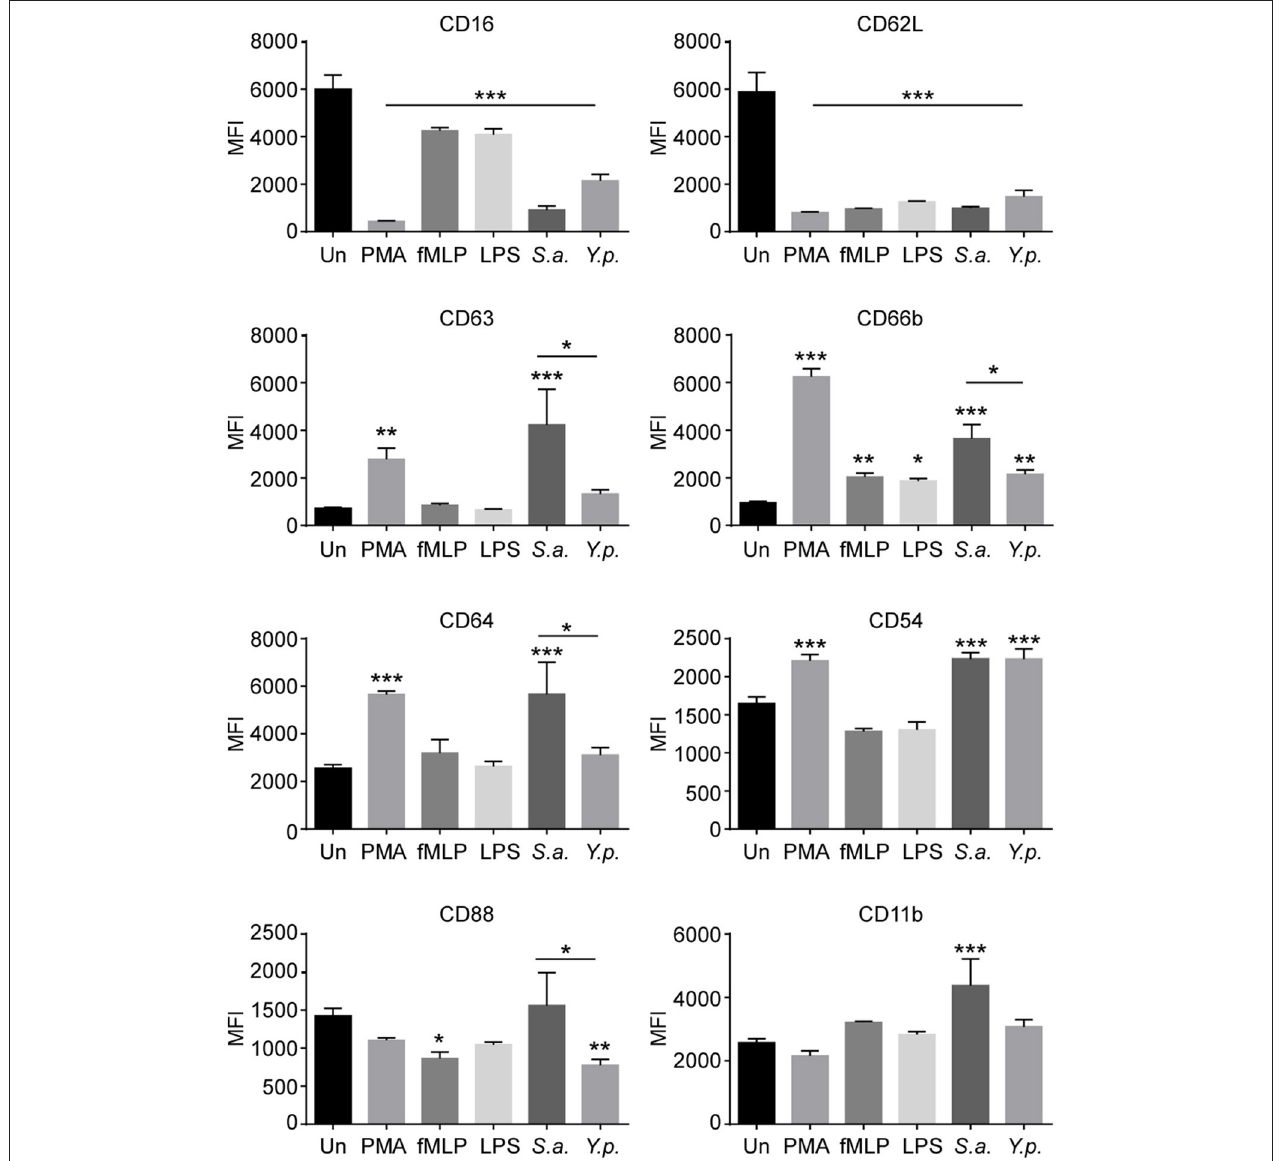
FIGURE 4 | Characterization of neutrophil activation and degranulation phenotype induced by Y. pestis infection. Neutrophils were infected with Y. pestis KIM6 + ( Y.p. ) or S. aureus ( S.a .) at an MOI of approximately 5. Other samples of neutrophils were activated with PMA, E. coli LPS, or fMLP as positive controls. Uninfected/untreated cells served as negative controls. At 4h post-infection/treatment, neutrophils were harvested and stained for surface expression of eight activation or degranulation markers and analyzed by flow cytometry. The mean fluorescence intensity (MFI) of each surface marker is shown. Error bars represent SD. The results shown are from one experiment done in triplicate and are representative of 3 independent experiments with neutrophils from different donors. MFIs were compared to uninfected/untreated control MFI by one-way ANOVA followed by Dunnett’s multiple comparison test. Statistical significance indicated is relative to uninfected/untreated control, unless otherwise indicated. An unpaired t -test was used for direct comparison between S. aureus and Y. pestis MFI. * p < 0.05, ** < 0.01, *** <